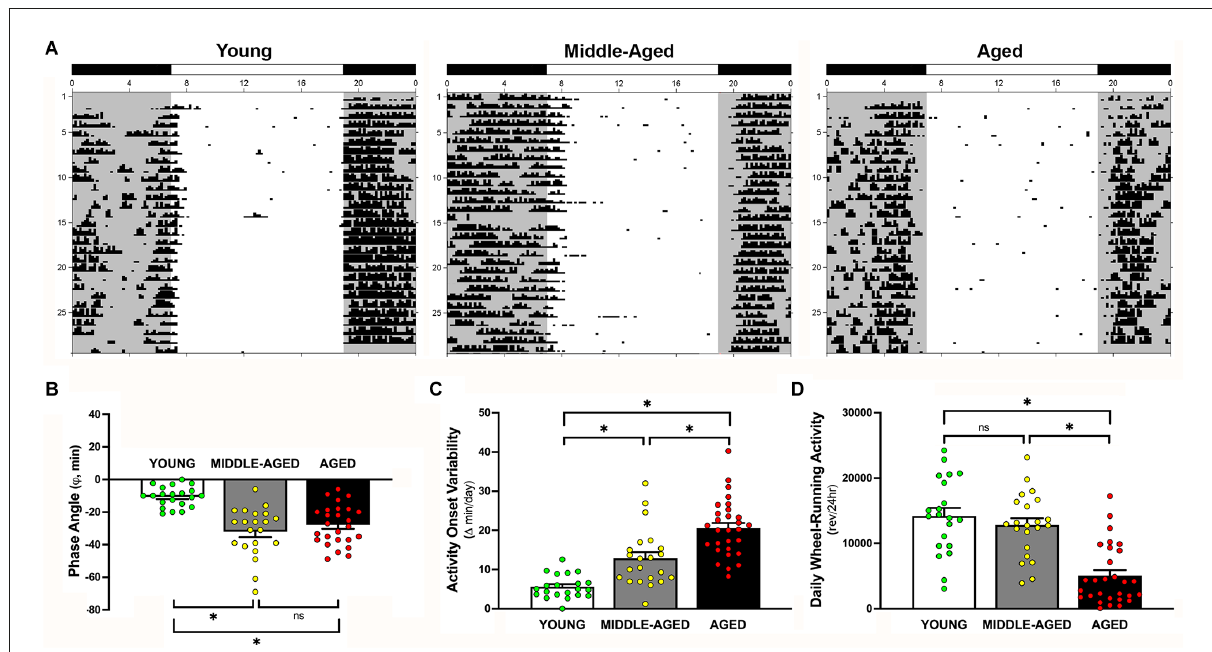
FIGURE4 Effects of aging on light-dark entrainment and other properties of the circadian rhythm of wheel-running activity in mice. (A) Representative records of circadian wheel-running behavior in young (left), middle-aged (center), and aged (right) mice during entrainment to LD 12:12. Actograms are plotted over a 24-h period. The closed bars at the top and shading on the records signify the timing of the dark phase in the LD 12:12 cycle. Comparisons of (B) the phase angle ( ϕ ) between daily activity onsets and lights-off, (C) absolute day-to-day variability, and (D) total daily wheel-running activity (wheel revolutions/24 h) in young, middle-aged, and aged mice during entrainment to LD 12:12. In panel (B) , negative phase angle values (in minutes) indicate that daily onsets of activity occur after lights-off whereas positive values denote that activity onsets precede the end of the light phase. Bars (in B–D ) depict Mean ± SEM values in young, middle-aged, and aged mice. Circles indicate individual scores of each mouse ( ∗ , Tukey’s multiple comparison; p < 0.0001; young vs. aged; middle-aged vs. aged; young vs. middle-aged, ns = non significant, p >